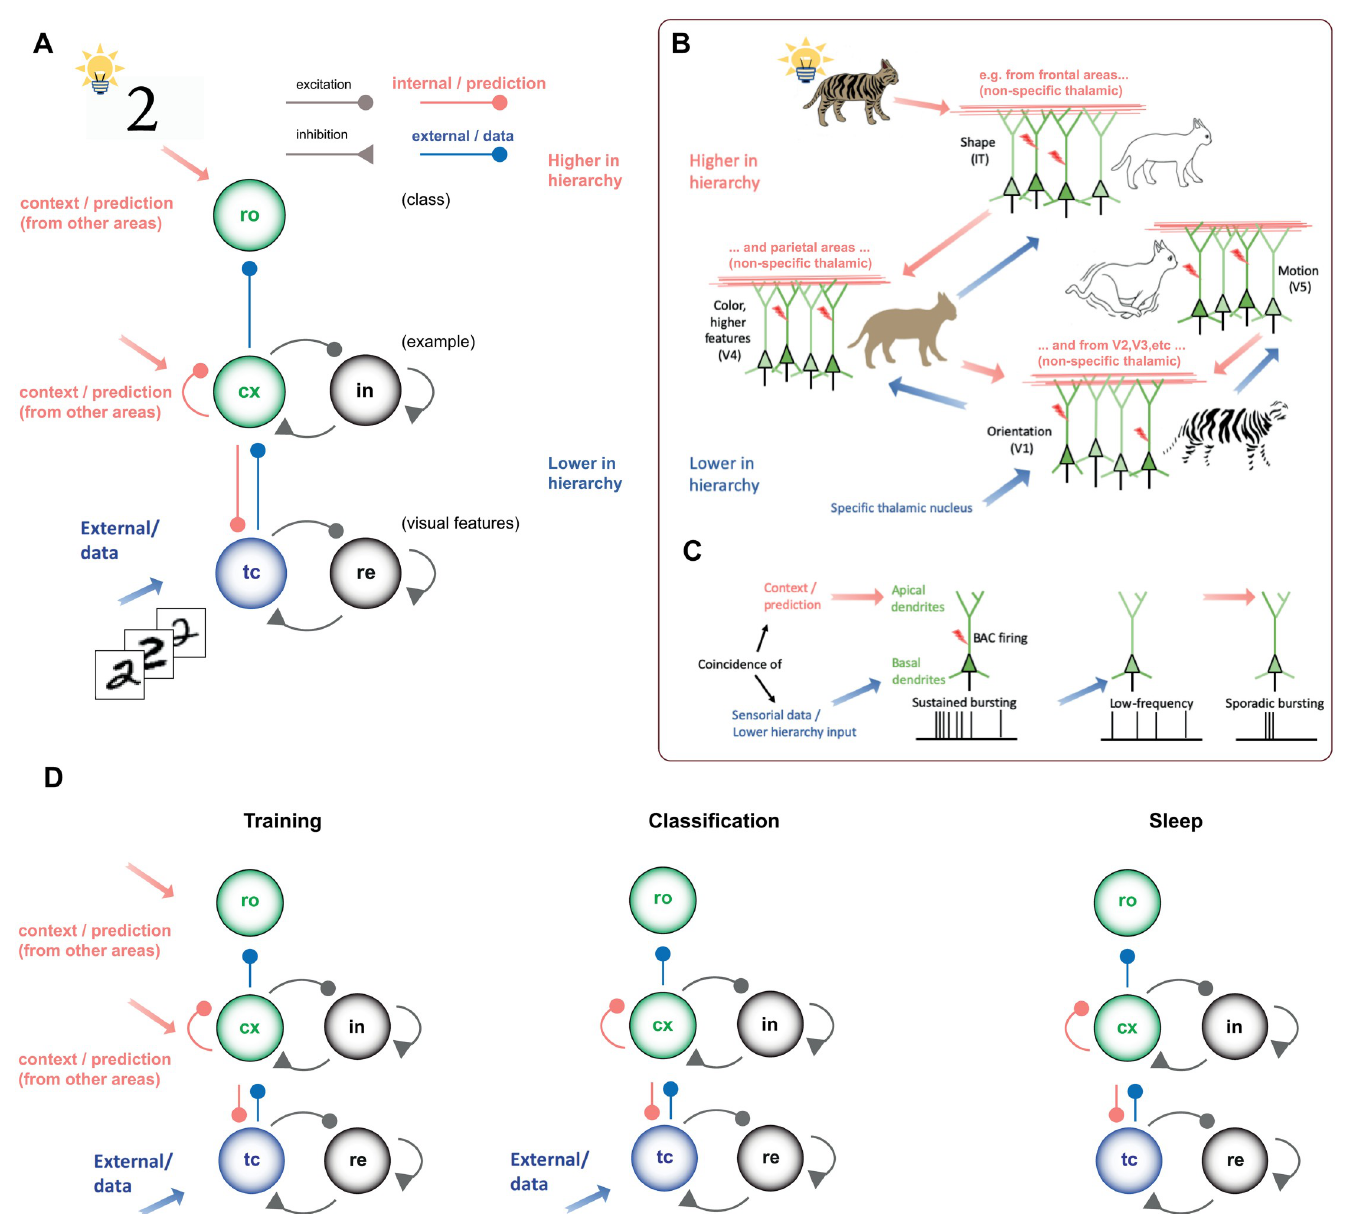
Fig 1. Thalamo-cortical spiking model (ThaCo). Panels B and C to compare the architecture of our model with the biological principles described in [1]. A) Scheme of the Thalamo-cortical spiking model (ThaCo). Input images, passed through a filter (HOG) are projected (blue arrow) to thalamic excitatory neurons ( tc ), mimicking the mechanism of the retinal visual stimulus . Thalamic neurons stimulate cortical excitatory neurons ( cx ) with a perceptual feedforward excitation (blue). Cortico- cortical and cortico-thalamic are considered as top-down prediction connections (red). (Red arrows—context/prediction) Currents coding for higher abstraction features incoming from other cortical areas. Cortical inhibitory neurons ( in ) arbitrate competition among cortical groups in a soft Winner-Take-All mechanism (WTA). Inhibitory reticular neurons ( re ) control the thalamic firing rate. The cortical layer is in turn connected to readout neurons ( ro ) B) A cellular mechanism for associating feed-forward and feedback signals. Low-level features are encoded in primary sensory regions and this signal propagates up the visual hierarchy (e.g. striate cortex (V1) sensitive to orientation, V4 sensitive to colour, V5 sensitive to motion, and inferior temporal (IT) cortex sensitive to shapes and objects). Higher-level areas provide feedback information (context or expectation) to lower areas. The ThaCo model presented in this paper is a single area model and the contextual signal is assumed to collect during training the knowledge carried by all other areas in the hierarchy (see red arrows in panel A). C) Conceptual representation of the back- propagation activated calcium (BAC) firing hypothesis supporting efficient binding of features and recognition. Pyramidal neurons receiving predominantly feed- forward information are likely to fire steadily at low rates, whereas the simultaneous presence of contextual and perceptual streams changes the mode of firing to bursts (BAC firing). This coincidence mechanism is mimicked in our ThaCo model. D) During training (left), the injection of contextual signal , plays the role of internal prediction and increases the perceptual threshold of a subset of cortical neurons. The simultaneous presence of perceptual and contextual promotes a high firing rate in such neurons, mimicking the BAC mechanism. Also, the simulataneous presence of the signal from the cortical layer and of the contextual signal promotes a high